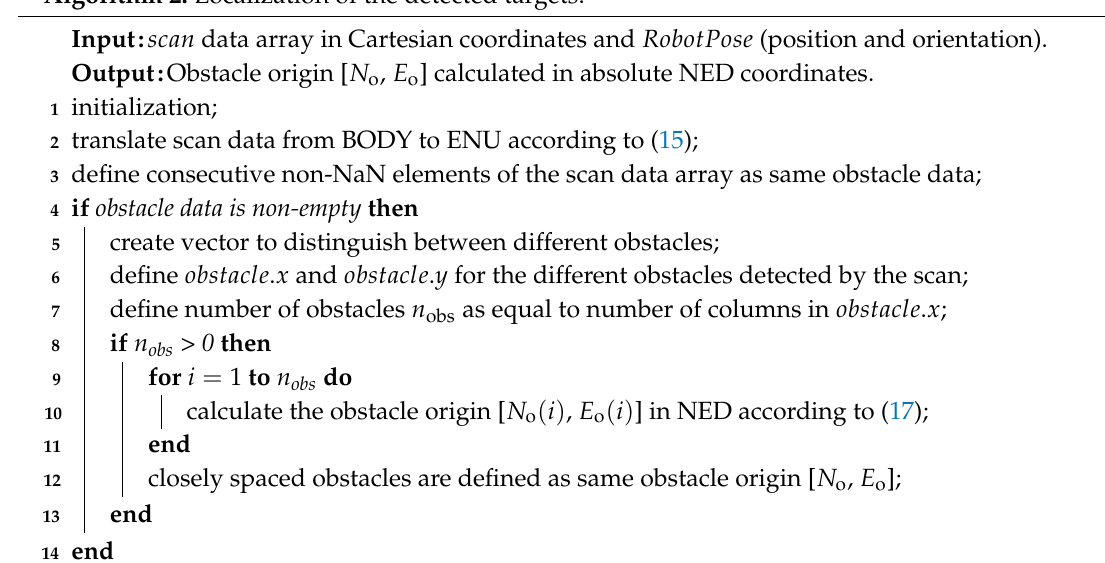
Algorithm 1. Finally, Figure 7c,d represents the origin position of the targets in NED coordinate system, with relative to origin [0,0] and absolute coordinates respectively.